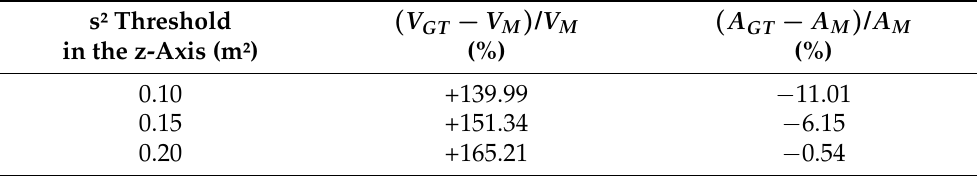
Table 6. Relative difference between the ground truth and the measured values for the canopy volume and occupancy area with respect to distinct z variance